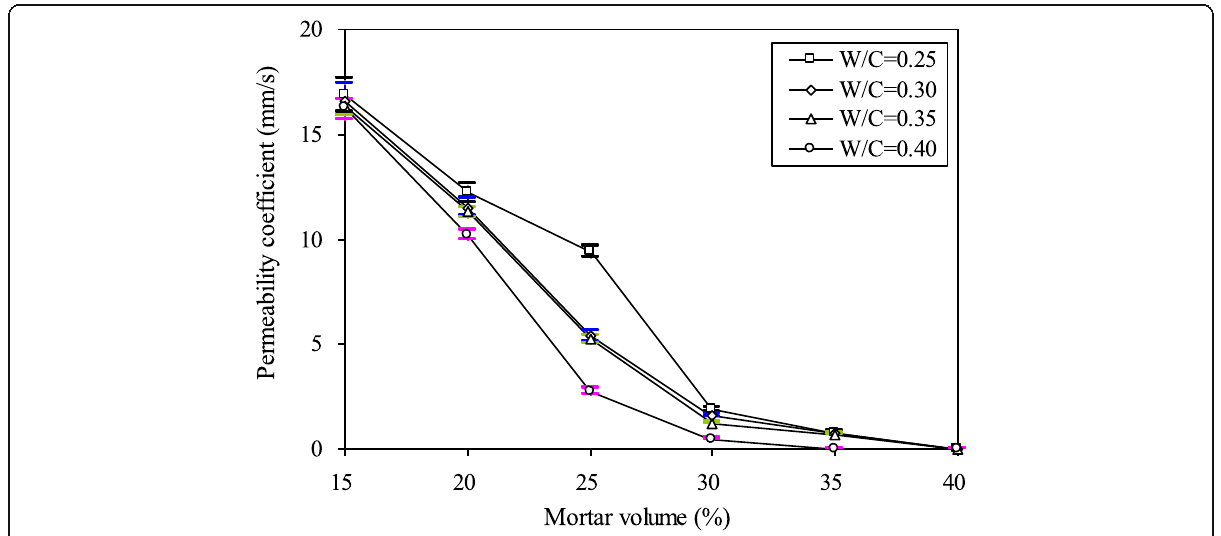
Fig. 8 Submerged permeability coefficient versus mortar volume for different W/C